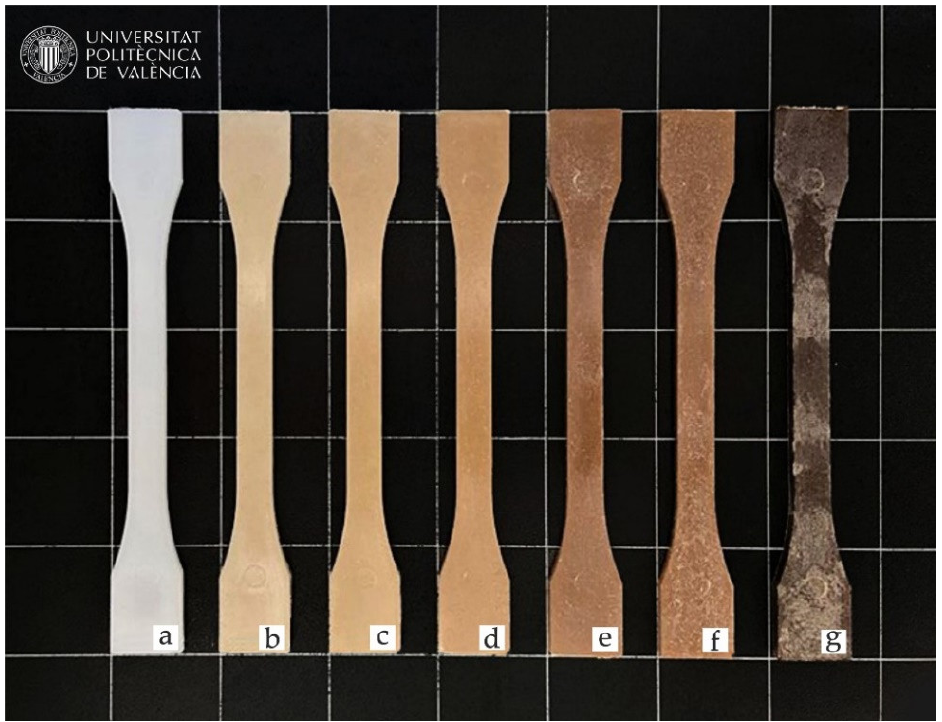
Figure 8. Visual appearance of the samples: ( a ) BioHDPE; ( b ) BioHDPE/2.5HF/PE-g-MA; ( c ) Bio- HDPE/5HF/PE-g-MA; ( d ) BioHDPE/10HF/PE-g-MA; ( e ) BioHDPE/20HF/PE-g-MA; ( f ) Bio- HDPE/20HF; ( g ) BioHDPE/40HF/PE-g-MA. Table 7. Luminance and color coordinates (L*, a*, b*) of BioHDPE/Hemp Fibers. Table 7. Luminance and color coordinates (L*, a*, b*) of BioHDPE/Hemp Fibers. Code L* Code BioHDPE